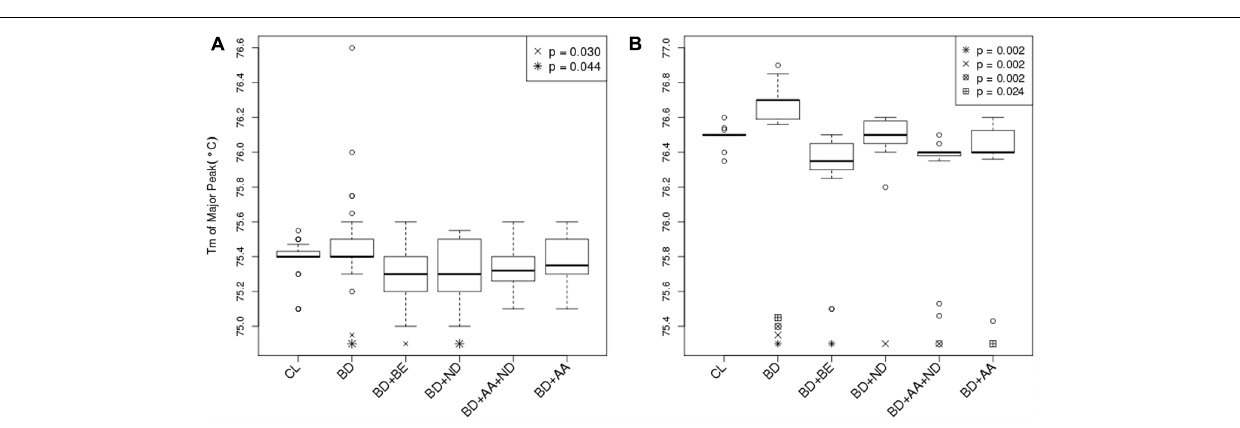
FIGURE 3 | Differential DNA methylation between BD and BD with addiction phenotypes. (A) Bar graph displayed Tm of major peak of amplicon 1 between –1759 and –1468 in the 5 (cid:48) UTR of the SLC1A2 as reported by HRM-PCR. Healthy control subjects (CL) ( N = 32); bipolar disorder (BD) without binge eating disorder or bulimia nervosa (BE), nicotine dependence (ND), and alcohol abuse or dependence (AA) ( N = 30); BD+BE ( N = 30); BD+ND ( N = 30); BD+AA+ND ( N = 30); BD+AA ( N = 30). (B) Bar graph displayed Tm of major peak of amplicon 2 between –785 and –654 in the 5 (cid:48) UTR of the SLC1A2 as reported by HRM-PCR. All groups ( N = 15). Symbols indicate a significant differences compared to BD only group ( p < 0.05, one-way ANOVA followed by post hoc pairwise tests adjusted for multiple comparisons using Bonferroni’s method). Data are expressed as median ±